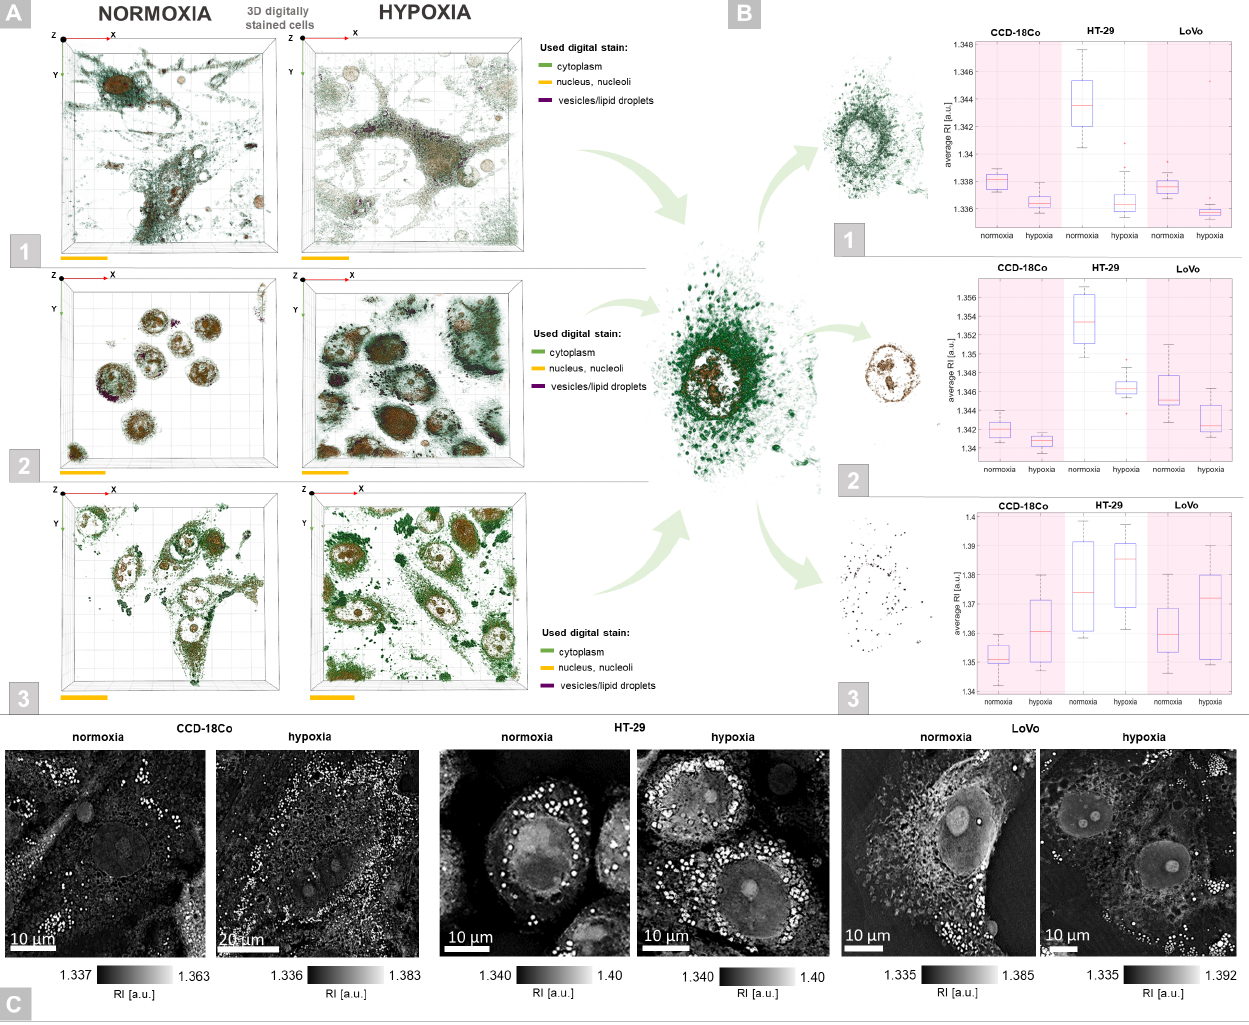
Figure 5. ( A ) The digitally stained 3D visualizations of CCD-18Co (1), HT-29 (2), and LoVo (3) cells under normoxic and hypoxic conditions (scale bars: 20 µ m). ( B ) The boxplots representing the variation of the average RI values of cytoplasm (1), nucleus and nucleoli (2), and vesicular content (3) and their digitally stained representative visualizations. ( C ) The representative 2D-RI tomograms indicating the location of vesicles/lipid droplet-like structures inside the